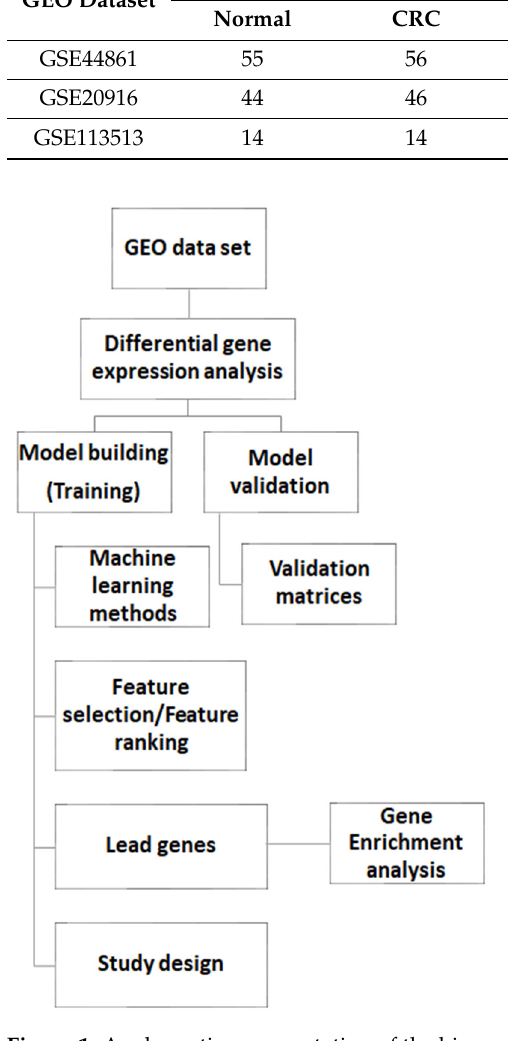
Table 1. List of the datasets and platforms used in this study. GEO Dataset